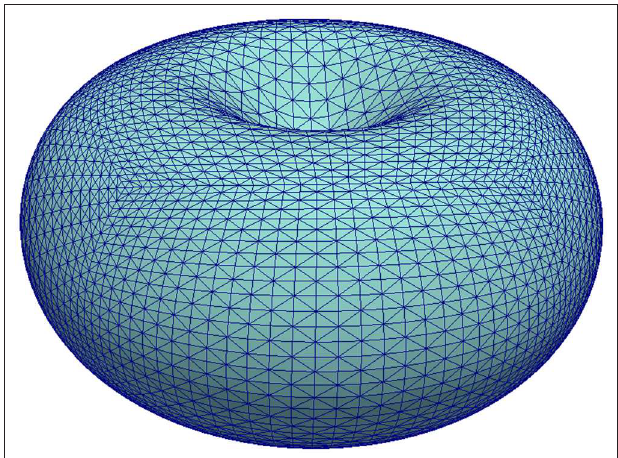
FIGURE 2 | Illustration of the initial shape used for the simulation in section 5.3 by means of its mesh Ŵ 0 h . For better visibility of the triangles, only ten bisections were performed resulting in a mesh with 20480 vertices. A finer mesh with 196608 vertices was used for the computations.